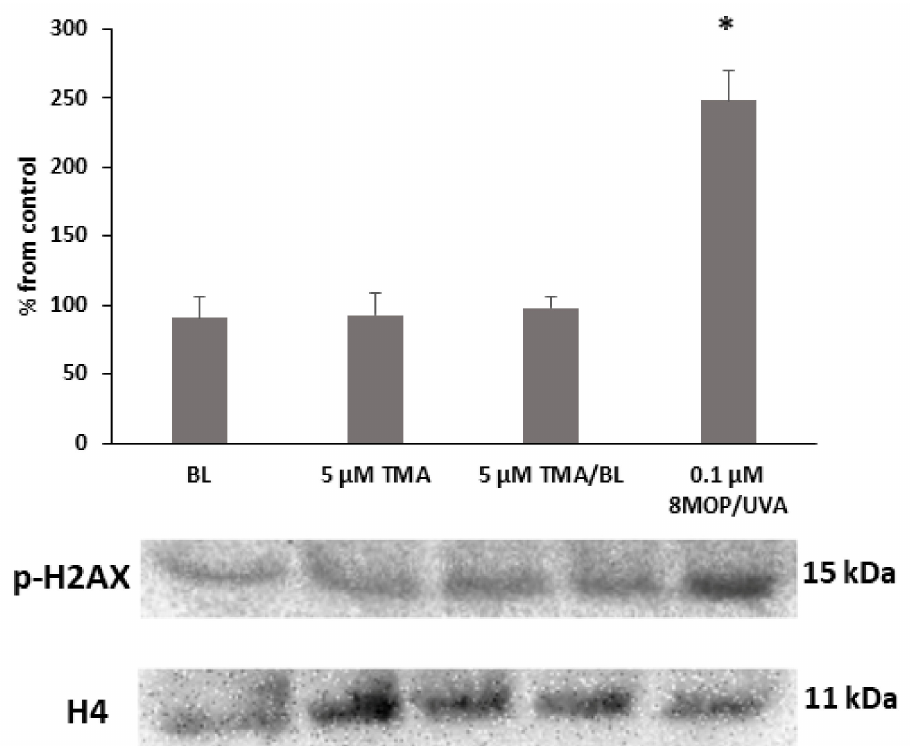
Figure 3. Western blot analysis of the phosphorylated form of the histone H2AX. The cultures were treated with 5- µ M TMA/BL (2 J/cm 2 ). Quantification of the expression levels was performed by a densitometric analysis using ImageJ software. Data, normalised to the H4 histone, are reported as percentages from the control cultures. * p < 0.05 vs. control. 8-MOP: